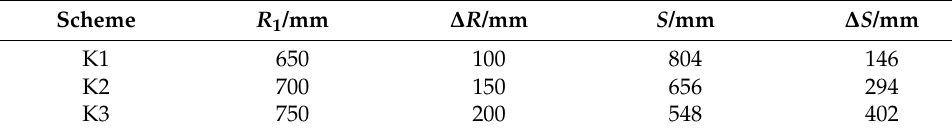
Figure 3. Sizes of target forging and preform (unit: mm): ( a ) target forging; ( b ) K2 preform. Table 1. Different preforming design